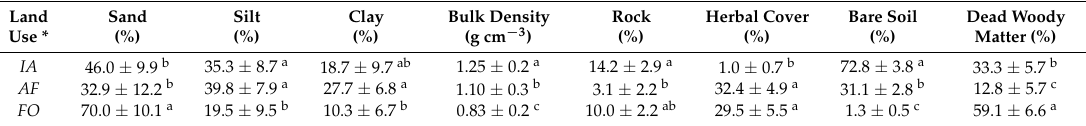
Table 1. Soil physical characteristics (mean ± standard deviation) in the study area (Villamalea, Castilla La Mancha, SE Spain). Different lower-case letters indicate statistically significant differences following LSD test ( P -value < 0.05).